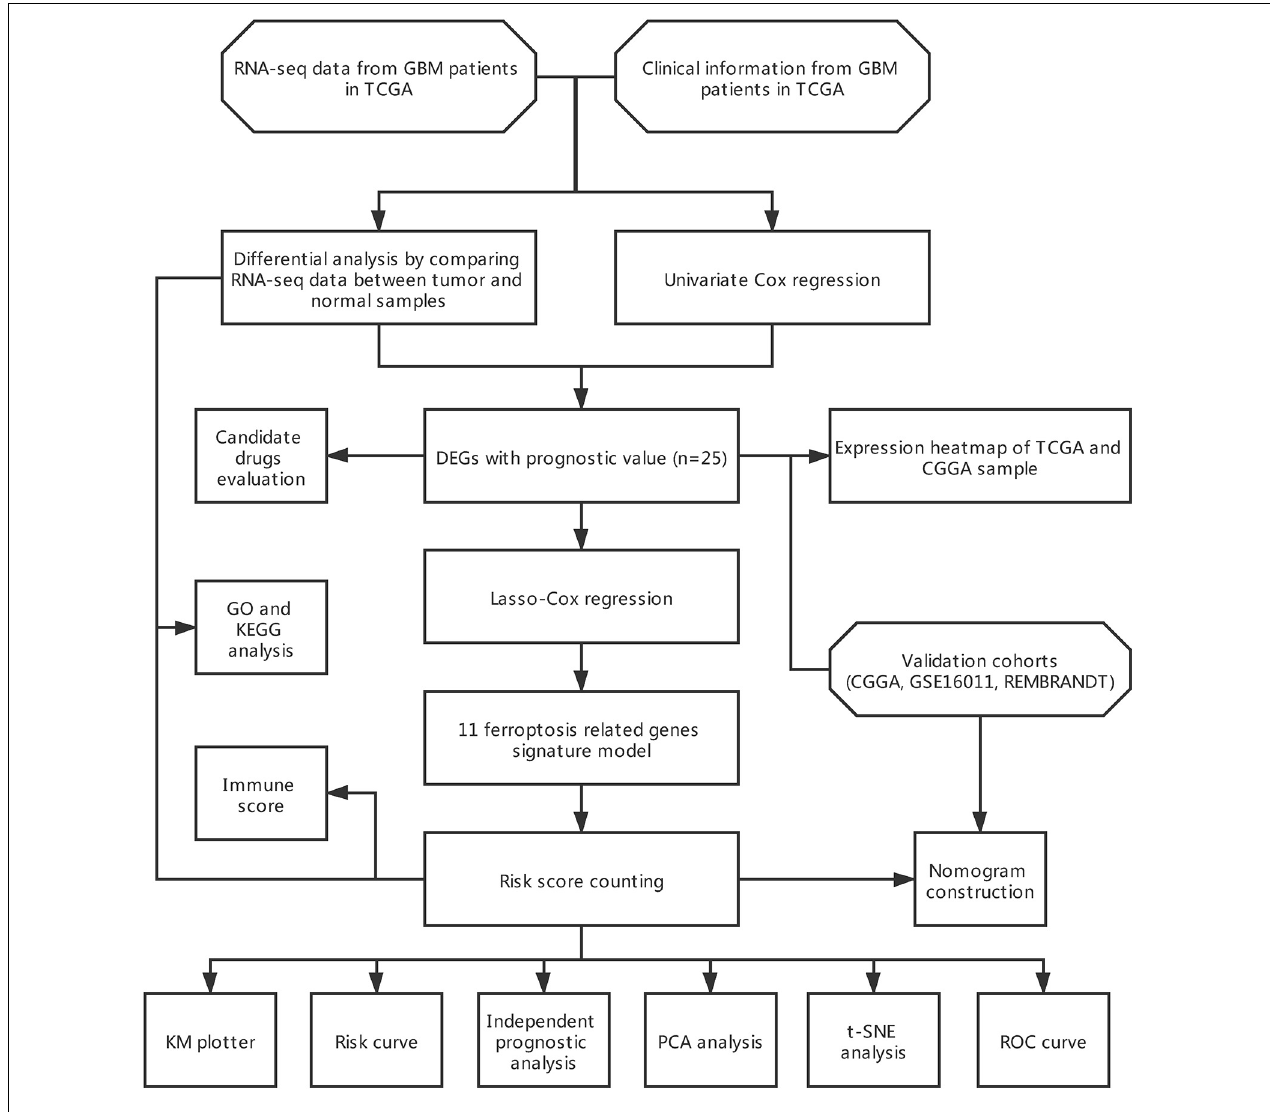
FIGURE 1 | Flow chart of the study.